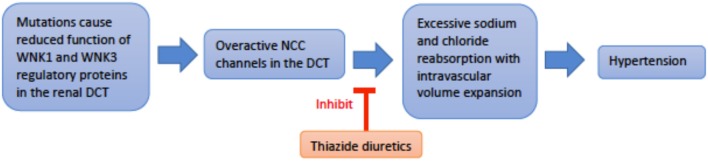
An overview schematic of Gordon Syndrome pathophysiology and treatment. NCC is the sodium chloride co-transporter; DCT is the distal convoluted tubule.